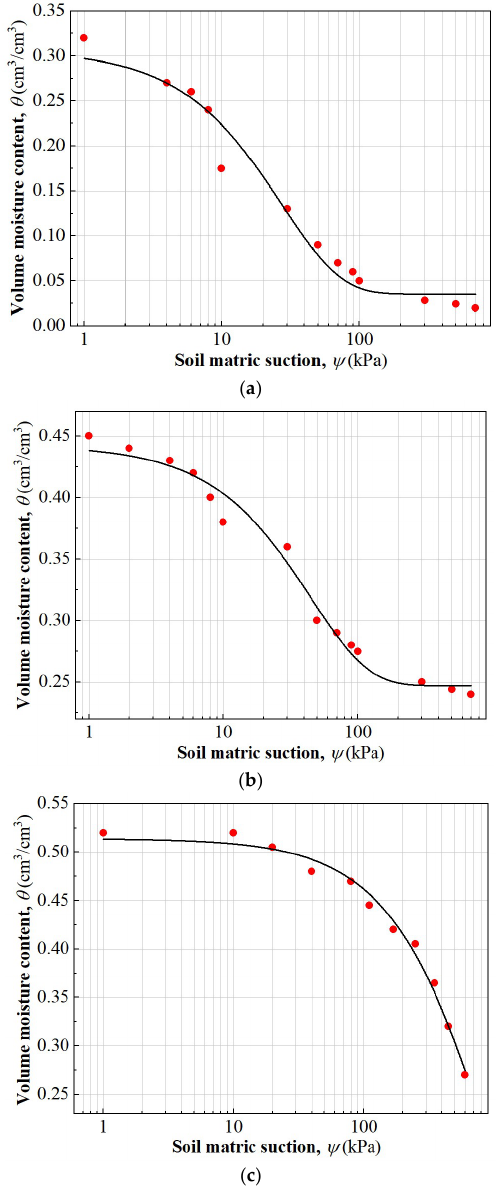
Figure 8. Soil water characteristic curve: ( a ) unconsolidated sand; ( b ) Touchet silty loam; ( c ) micro- silica.